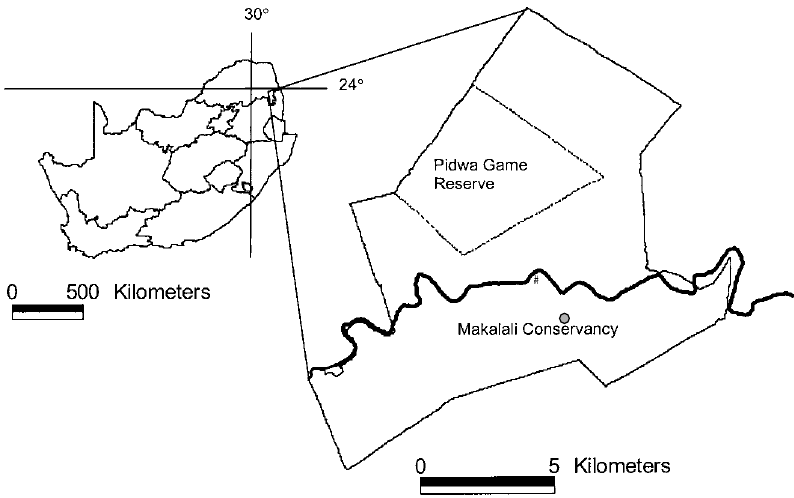
Fig. 1. The Greater Makalali Conservancy with the Pidwa section before the fences were removed (dashed line) in October 2000. The black line through the Conservancy indicates the Makhutswi River and the circle near the centre of the Conservancy indicates the location of the lion release